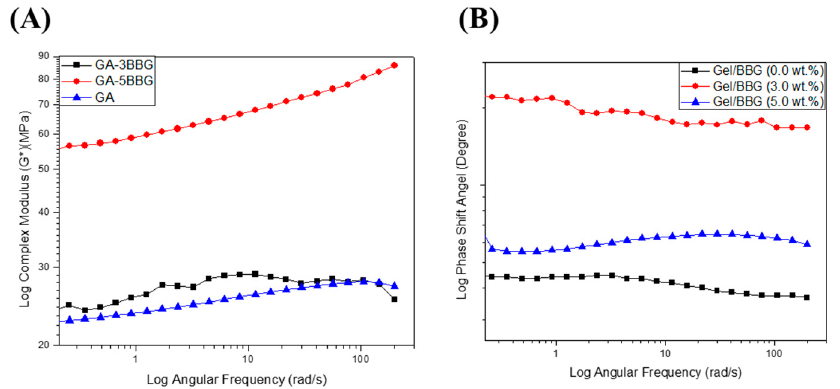
Figure 7. Log scale of ( A ) complex shear modulus (G*) and ( B ) phase shift angle of the B/BBG nanocomposite hydrogels as a function of the angular frequency.